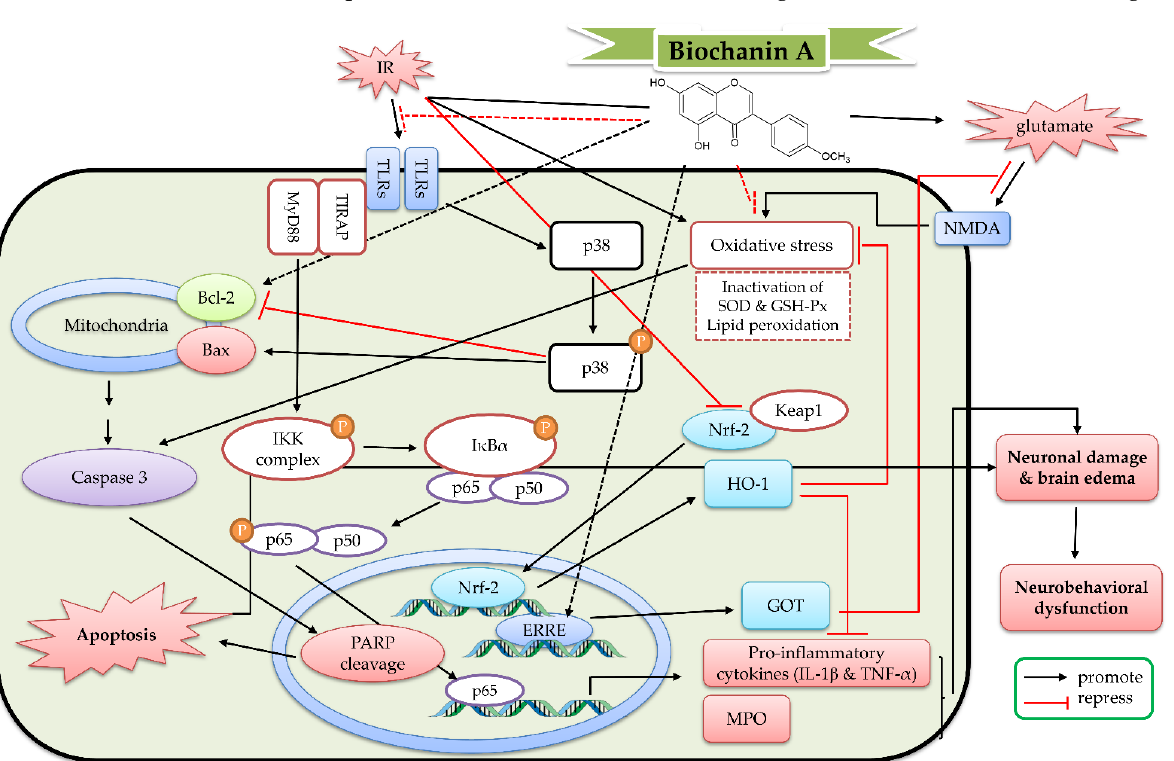
Figure 7. The protective effects of biochanin A against cerebral ischemia reperfusion (IR). Bax, Bcl-2-associated X protein; Bcl-2, B-cell lymphoma 2; ERRE, estrogen-related receptor response element sites; GOT, glutamate oxaloacetate transaminase; GSH-Px, glutathione peroxidase; HO-1, heme oxygenase-1; I κ B α , Inhibitor kappa B α ; IKK, I κ B kinase; IL-1 β , interleukin-1 β ; IR, ischemia reperfusion; Keap1, Kelch-like ECH-associated protein 1; MPO, myeloperoxidase; MyD88, myeloid differentiation primary response 88; NMDA, N-methyl-D-aspartate; Nrf-2, nuclear factor erythroid 2-related factor 2; PARP, Poly (ADP-ribose) polymerase; SOD, superoxide dismutase; TIRAP, Toll-interleukin-1 receptor domain-containing adapter protein; TLR, Toll-like receptor; TNF- α , tumor necrosis factor α